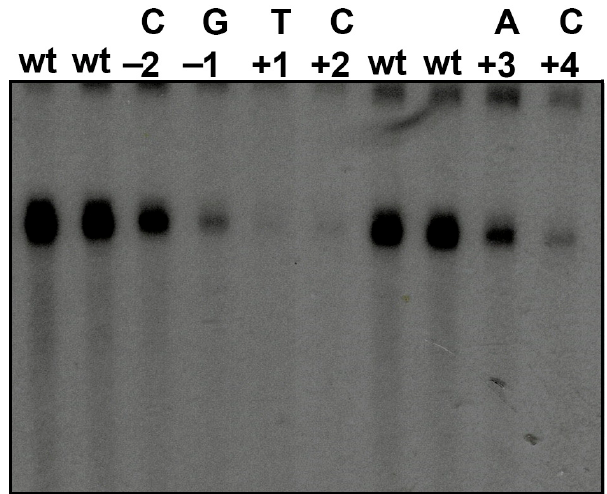
Figure 3. Mutations in conserved positions impairs transcription initiation. Those conserved positions were changed to bases, as indicated at the top of the figure. It can be observed that mutations on conserved positions at − 1, +1, +2, and +4 impair transcription initiation of the nmt1 Inr-containing promoter (indicated as wt).